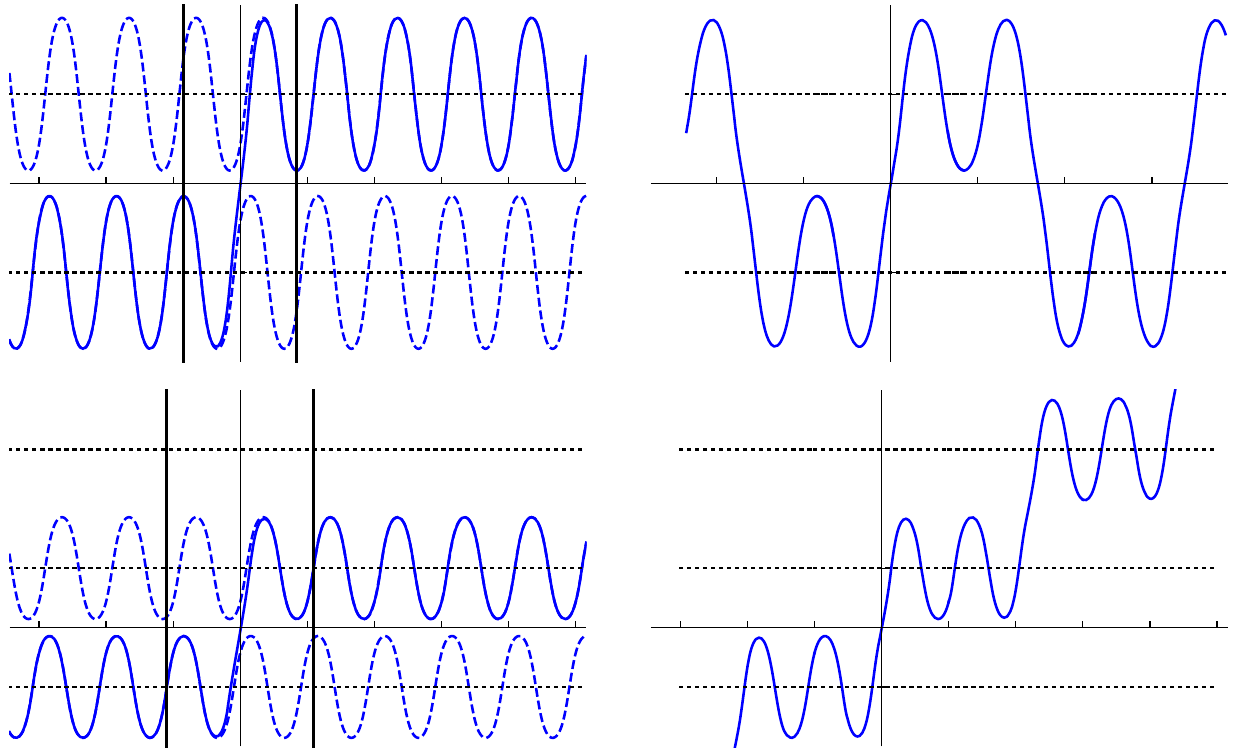
Fig. 14 On the left, the kink solution propagating on top of an elliptic background, a degenerate genus two solution of the sine-Gordon equation. The part of this solution between the thick vertical black lines is used to approximate the non-degenerate genus two solution depicted on the right